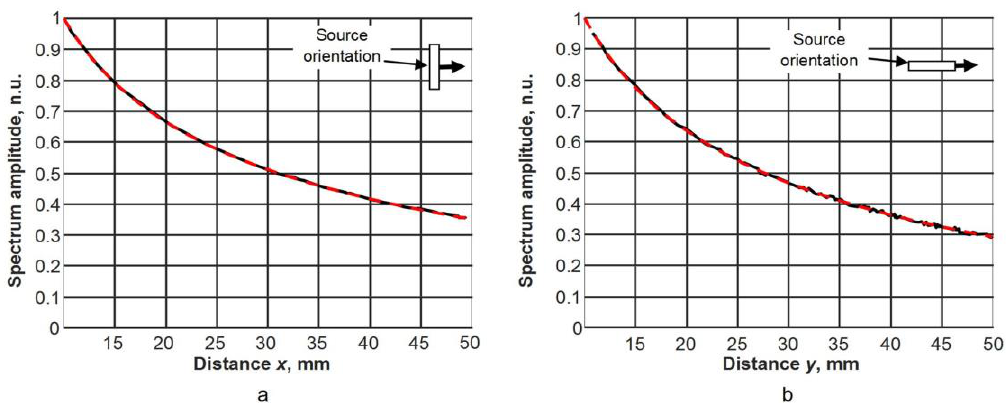
Figure 7. Dependence of spectrum amplitudes at 44 kHz on the distance from the excitation zone. ( a ) Results obtained along the x axis, ( b ) results obtained along the y axis. Solid line—finite element modelling data, dashed line—curve fitting.